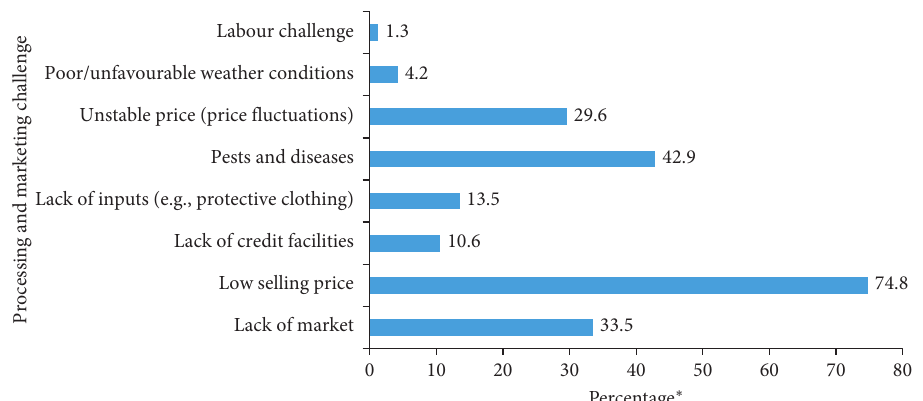
Figure 13: Constraints to kola processing and marketing in Ghana ( ∗ multiple responses).